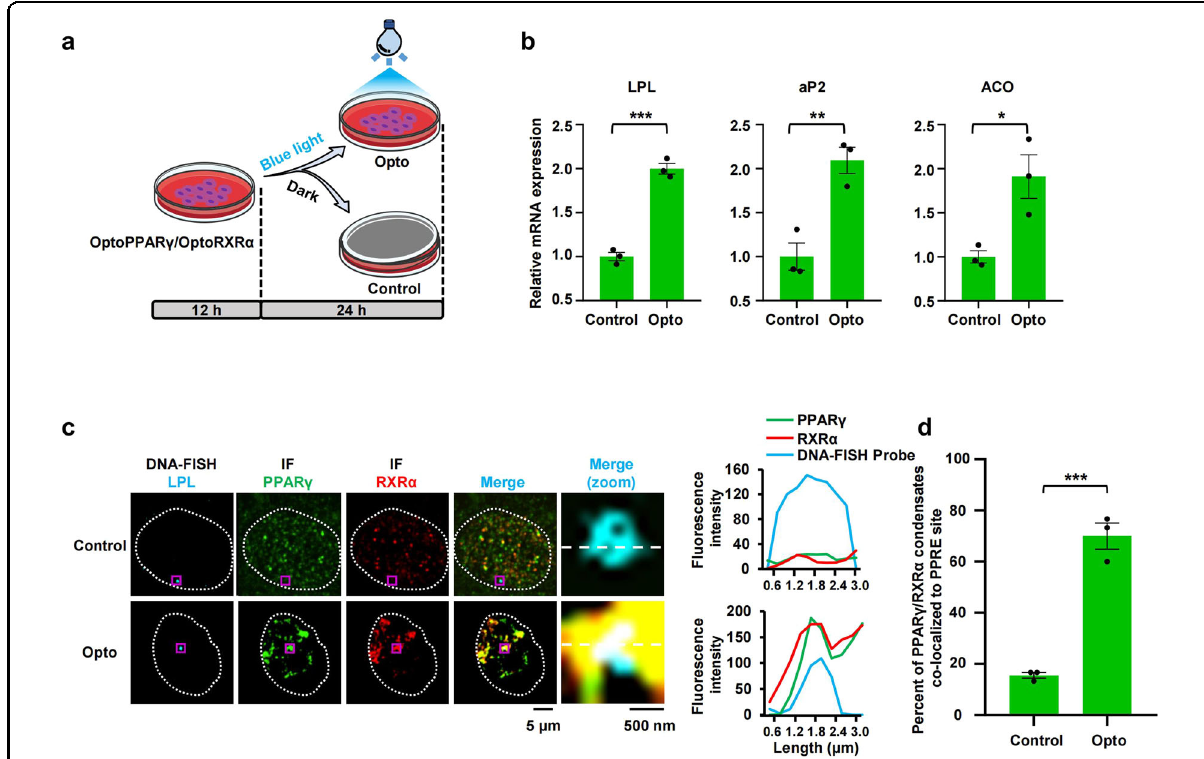
Fig. 4 Enforced formation of PPAR γ /RXR α condensates remarkably generate speci fi c downstream outcomes. a Schematic timeline of seeding and blue light illumination of pre-3T3-L1 cells. 3T3-L1 cells with stable expression of optoPPAR γ and optoRXR α were seeded in the dish for 12 h and then treated by blue light for 24 h. Dark-treated cells were referred as Control, and blue light-treated cells were referred as Opto. b RT-qPCR analysis of LPL, aP2, and ACO transcription levels in dark-treated cells and light-treated cells. Data are shown as means ± SEM ( n = 3). c Colocalization between optoPPAR γ /optoRXR α heterodimer puncta and LPL-PPRE locus by IF and DNA-FISH in fi xed Control-3T3-L1 cell and Opto-3T3-L1 cell ( n = 50). Separate images of the indicated LPL-PPRE probe ( fi rst column), PPAR γ (second column) and RXR α (third column) are shown, accompanied with an image showing the merged channels (the fourth column, overlapping signal in white). Scale bar, 5 μ m. The fi fth column (merge (zoom)) displays the magni fi cation of the purple box region in the fourth column for greater detail. Scale bar, 500 nm. Right panel, the line plot corresponding to magni fi ed image. d Quanti fi cation of DNA-FISH analysis using percentage of cells with PPAR γ /RXR α condensates and LPL-PPRE locus colocalization in fi xed Control- and Opto-3T3-L1 cell ( n = 3). Data are shown as means ± SEM. Statistics: two-tailed unpaired t -test. *P < 0.05, ** P < 0.01, *** P < 0.001, **** P < 0.0001. ns, not signi fi